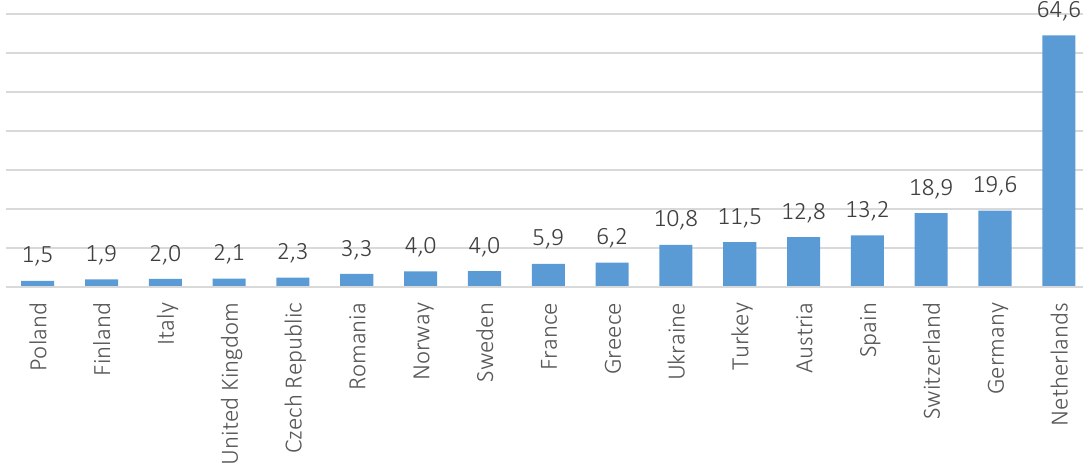
Figure 12. The share of health insurance in gross insurance premiums, %